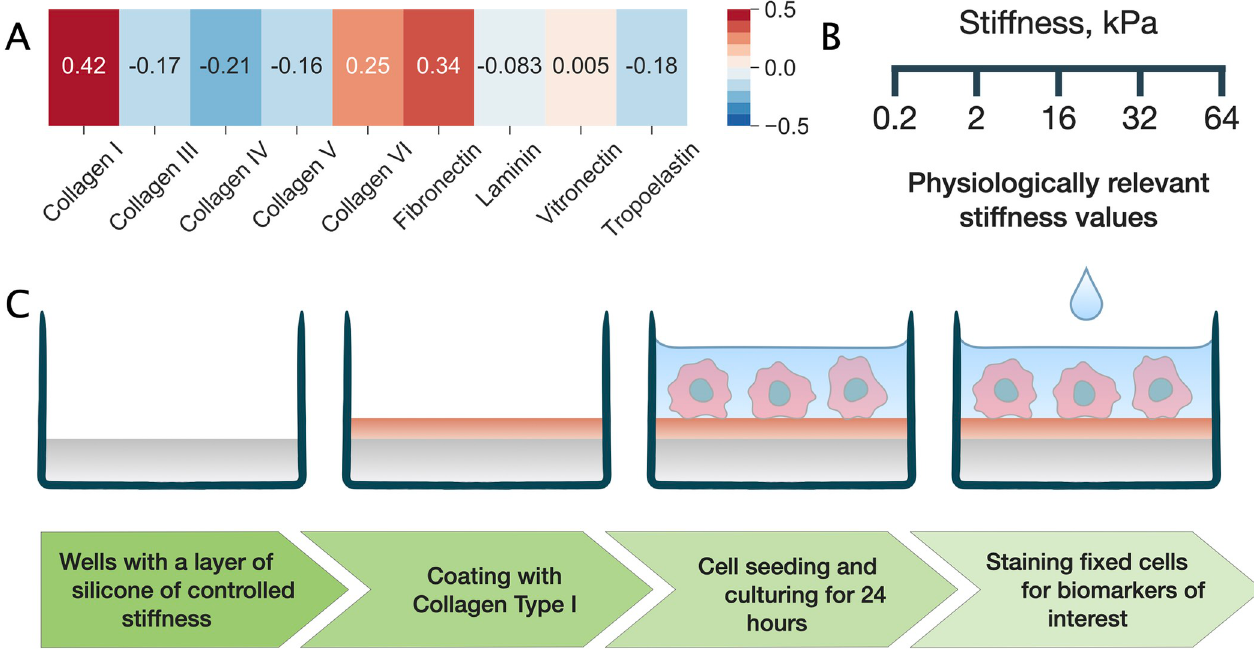
Fig 1. Choice of ECM protein coating and experimental design. (a) A heat map shows the values of Pearson’s correlation coefficient measuring the association between ECM protein concentration and the number of cells attached. (b) Substrate stiffness values investigated in this study. (c) In the designed experiment, MDA-MB-231 cells were seeded on silicone substrates of different stiffness coated with collagen type I. Afterwards, cells were cultured for 24 h, fixed, stained for biomarkers of interest and imaged using confocal microscopy.